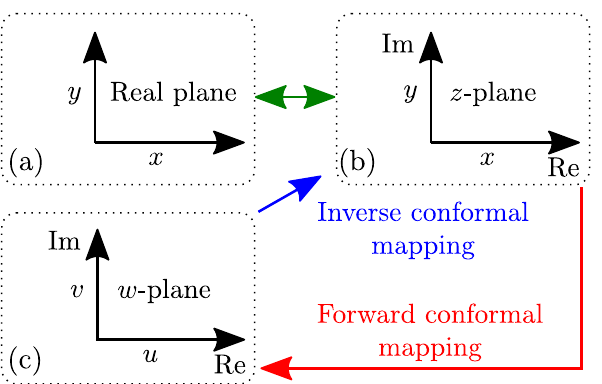
Figure 9. Mapping workflow, Subfigures ( a )–( c ) are explained within the Section 5.2. SyRM rotor has a circular layout which can be exploited by selecting the convenient complex function f ( z ) and applying forward conformal mapping to a complex w -plane ( w = u + j v ) , Figure 9c. Geometrical modifications of the barrier geometry are then performed in w -plane and upon completion, returned back to z (and real) plane via inverse conformal mapping. The benefit of the approach is easier barrier modification which leads to simplified software